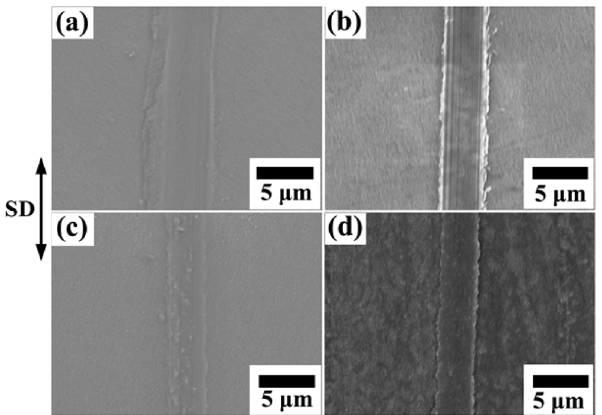
Fig. 3 Top view SEM micrographs of typical surface damage morphology in different NT Cu alloys after 100 sliding circles: (a) Cu-2wt.%Al alloy; (b) Cu-4wt.%Al alloy; (c) Cu-6wt.%Al alloy; (d) Cu-10wt.%Ni alloy. Double pointed arrow indicates the sliding direction (SD) for all samples.